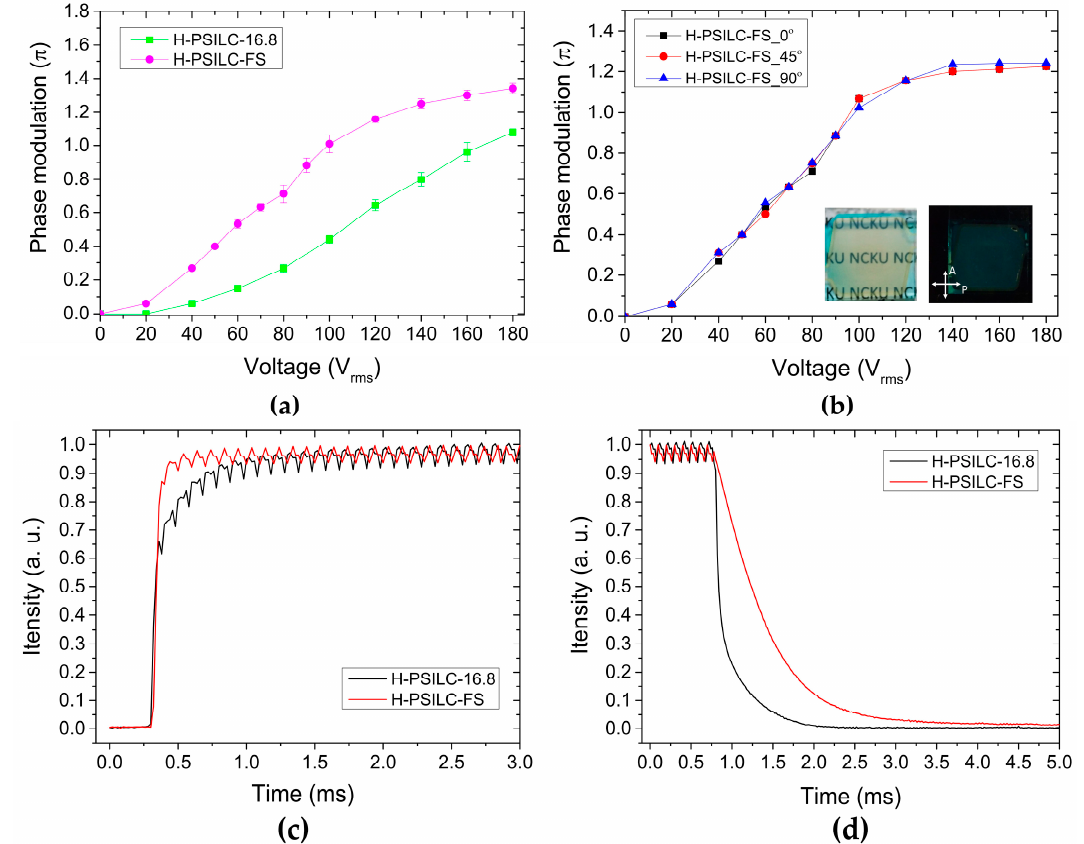
Figure 6. Comparisons of the electro-optical performances in H-PSILC-16.8 and H-PSILC-FS cells: ( a ) Electric phase modulation; ( b ) Electric phase modulation with respect to various incident linear polarizations in H-PSILC-FS cells. Inserts show the transparent and off (dark) states observed with a pair of crossed polarizers; ( c ) Measurements of transient rising time; ( d ) Measurements of transient falling time.